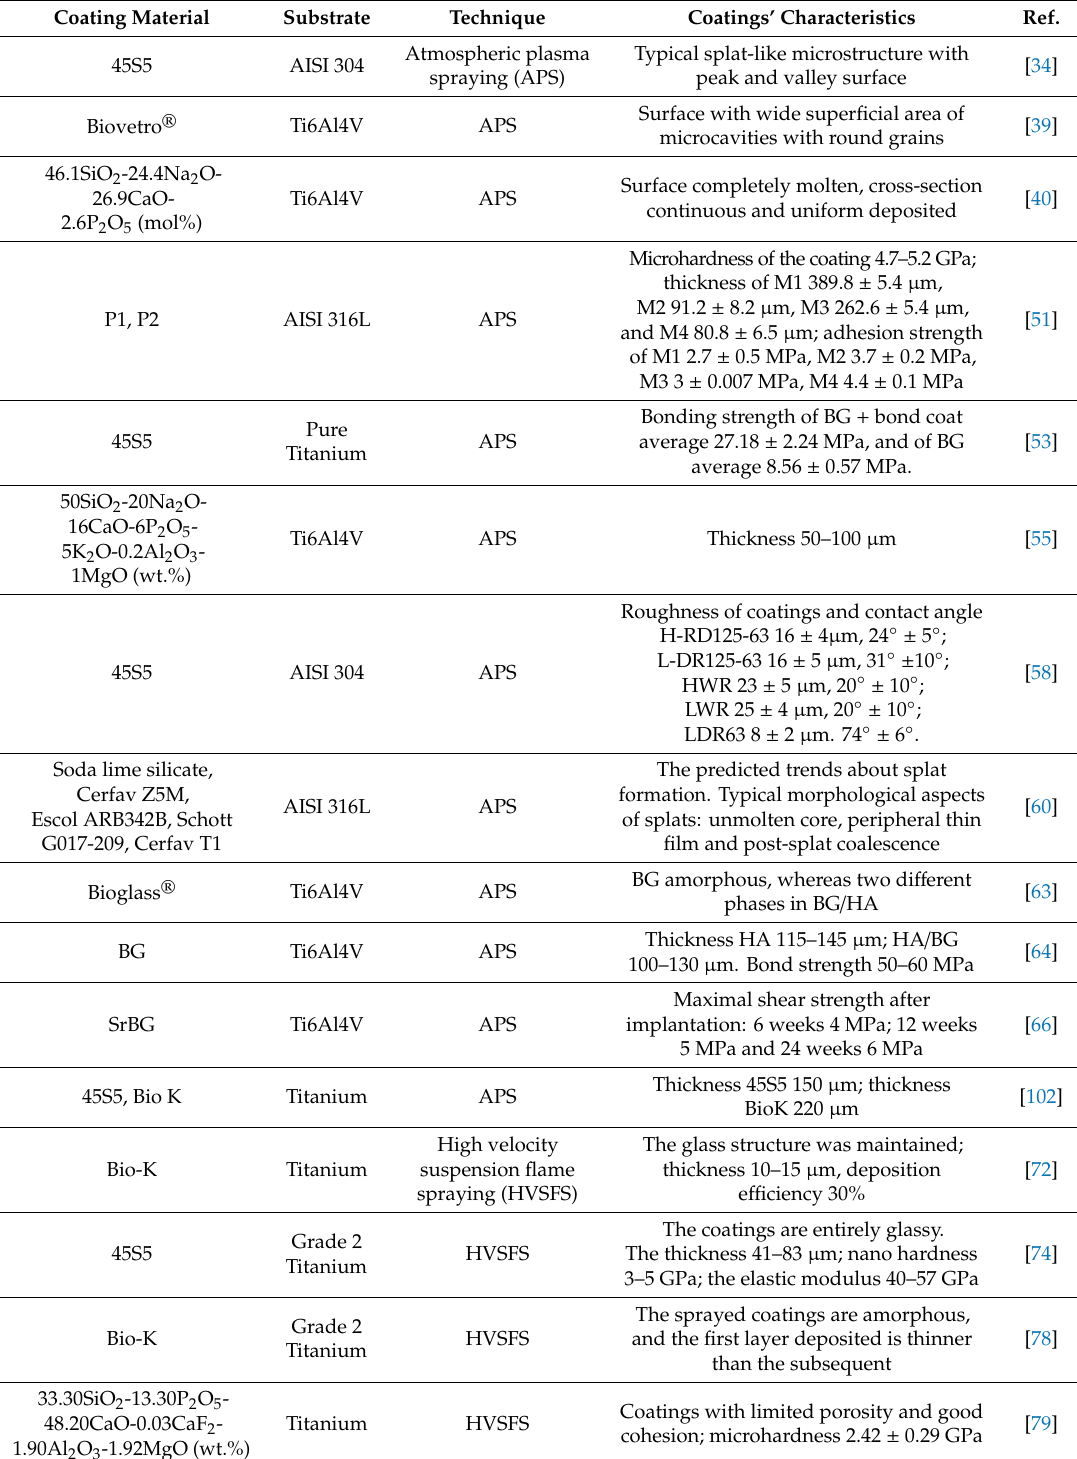
Table 1. Summary of bioactive glass coatings obtained by thermal spraying